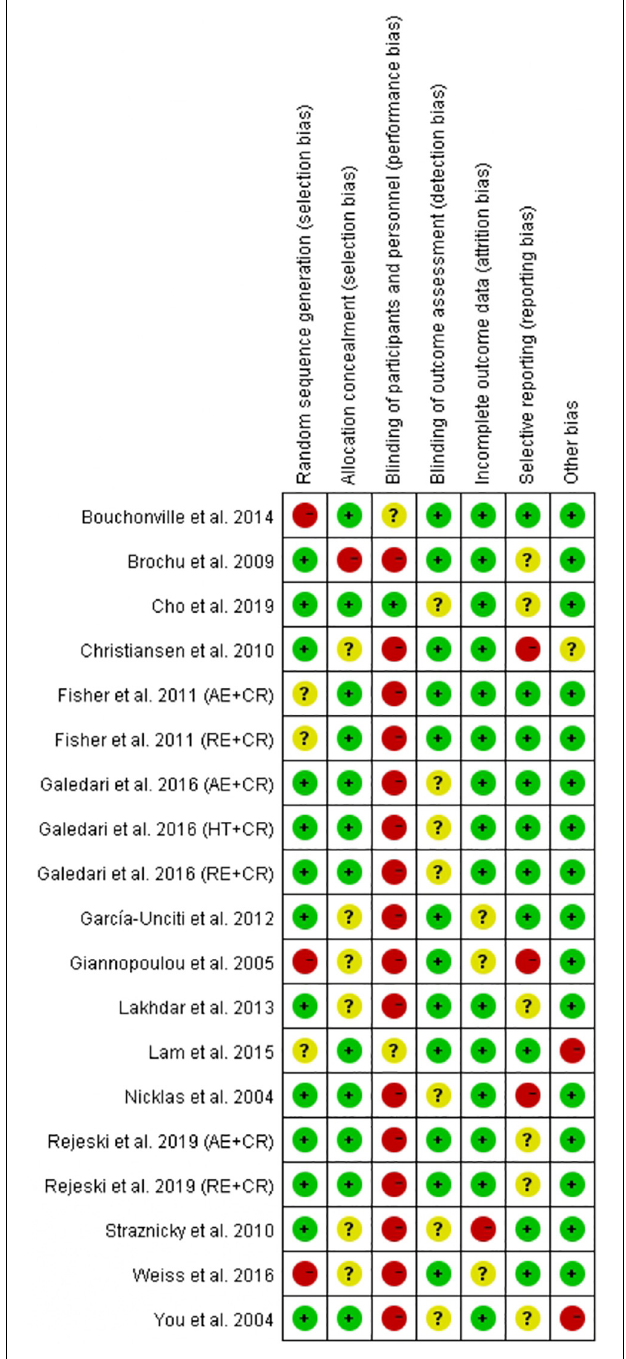
FIGURE 5 | Summary of the risk of bias for the trials included in this meta-analysis.